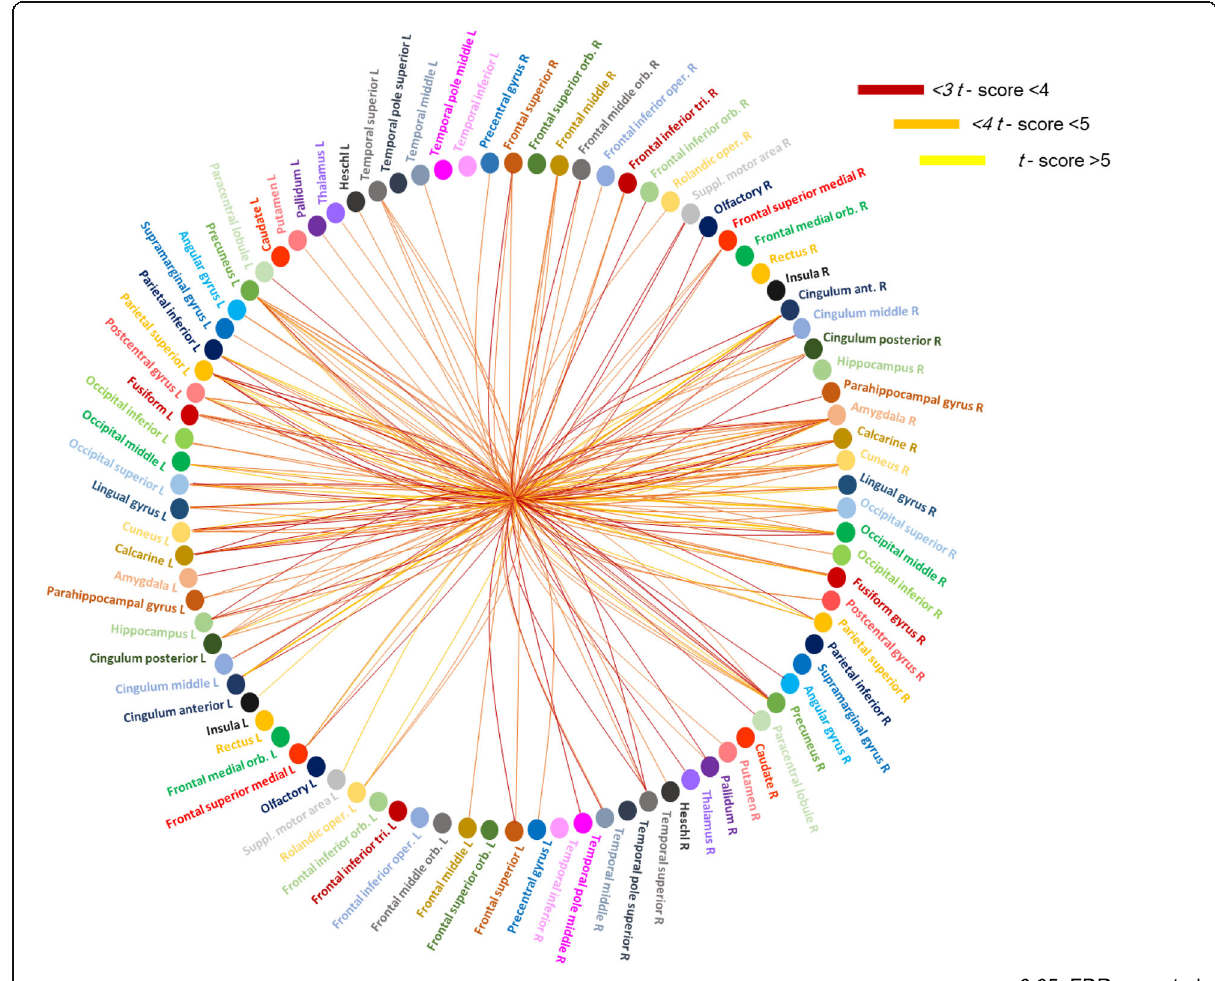
Fig. 4 Connectogram of nodes and edges showing significantly higher connection probability ( t score) in precuneus, cuneus, amygdala, calcarine cortex, posterior cingulate cortex, anterior cingulate cortex, postcentral gyrus, superior parietal lobule, lingual and fusiform gyri, middle frontal gyrus and inferior and superior parietal lobules in MwoA patients compared to HC data sets ( p < 0.05 corrected for multiple